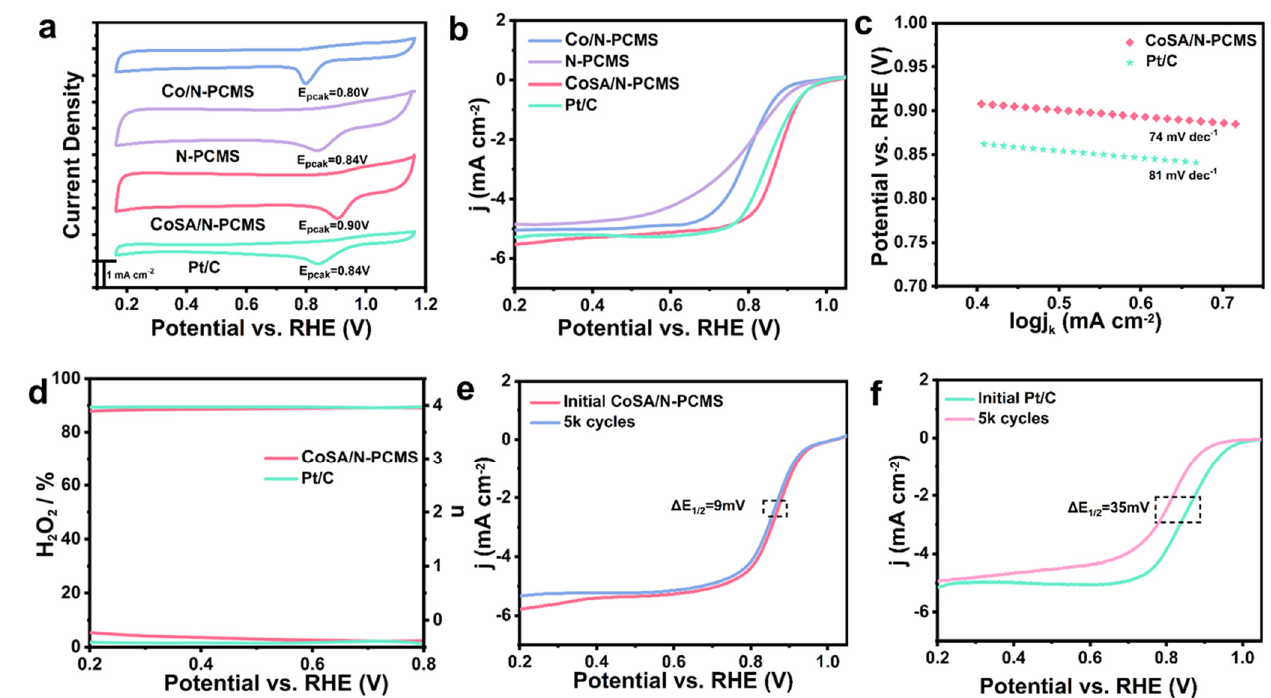
Figure 4. ( a ) CV curves and ( b ) LSV curves of CoSA/N − PCMS, N − PCMS, Co/N − PCMS, and Pt/C. ( c ) Tafel plots and ( d ) electron transfer number (n) and H 2 O 2 yield of CoSA/N − PCMS and Pt/C. ADT test of ( e ) CoSA/N − PCMS and ( f ) Pt/C for 5000 cycles.